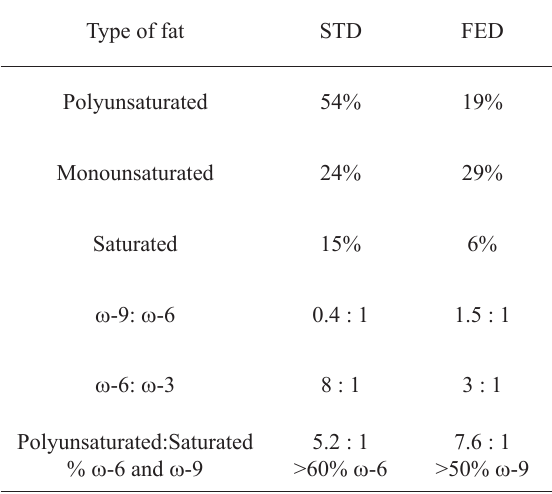
TABLE 3 - Lipid profile and ratios between ω-3, ω-6 and ω-9 fatty acids in STD and